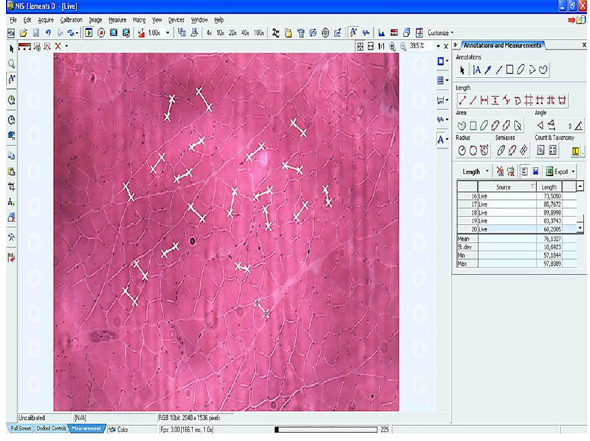
Figure 2 - NIS-Elements D3.0 - SP7 - Nikon ® Software and measure- ment of the smallest